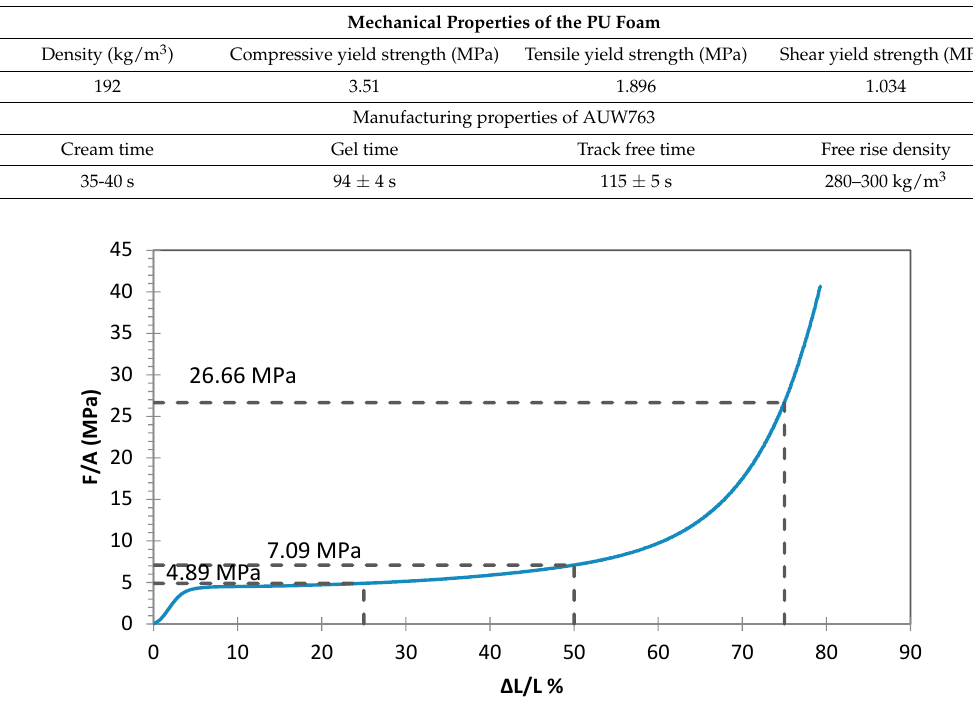
Figure 2. Results of the uniaxial load test on PU foam.